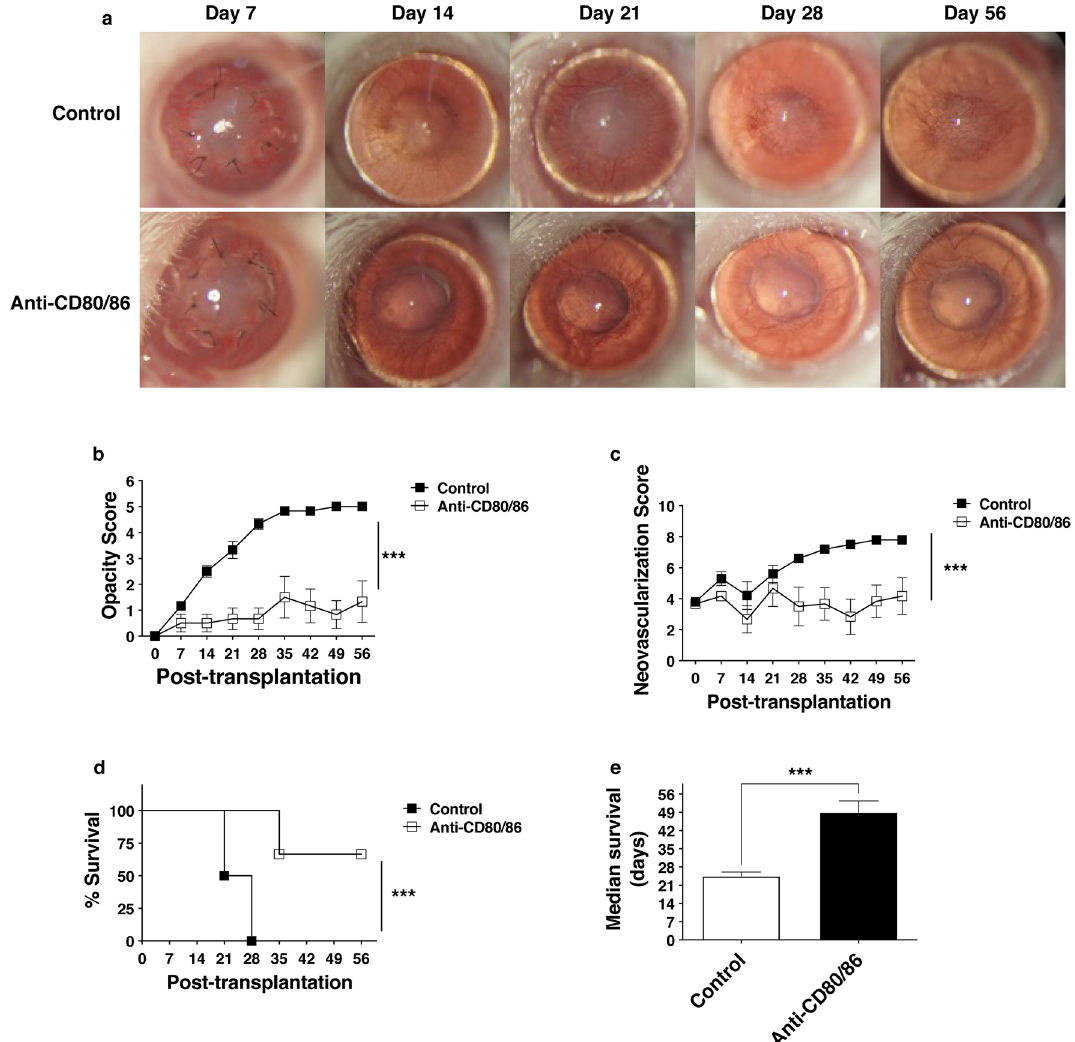
Figure 3. Anti-CD80/86 antibody injection prolongs corneal graft survival. ( a ) Representative slit-lamp microscopy showing grafted corneas on day 56 post corneal transplantation. ( b ) Graft opacity scores reduced significantly in grafts with anti-CD80/86 injection compared with that in the control group (two-way ANOVA, n = 6/group; *** P < 0.001). ( c ) The neovascularization score was considerably reduced in grafts with anti-CD80/86 injection compared with that in the control group (two-way ANOVA, n = 6/group; *** P < 0.001). ( d ) Kaplan–Meier survival curves show a significant increase in the survival of grafts with anti-CD80/86 injection compared with that in the control group (log-rank test, n = 6/group, *** P < 0.001). ( e ) The median graft survival shows that only grafts with anti-CD80/86 injection significantly improved graft survival in high-risk recipients to levels observed in the control group (unpaired t -test, n = 6/group. *** P <